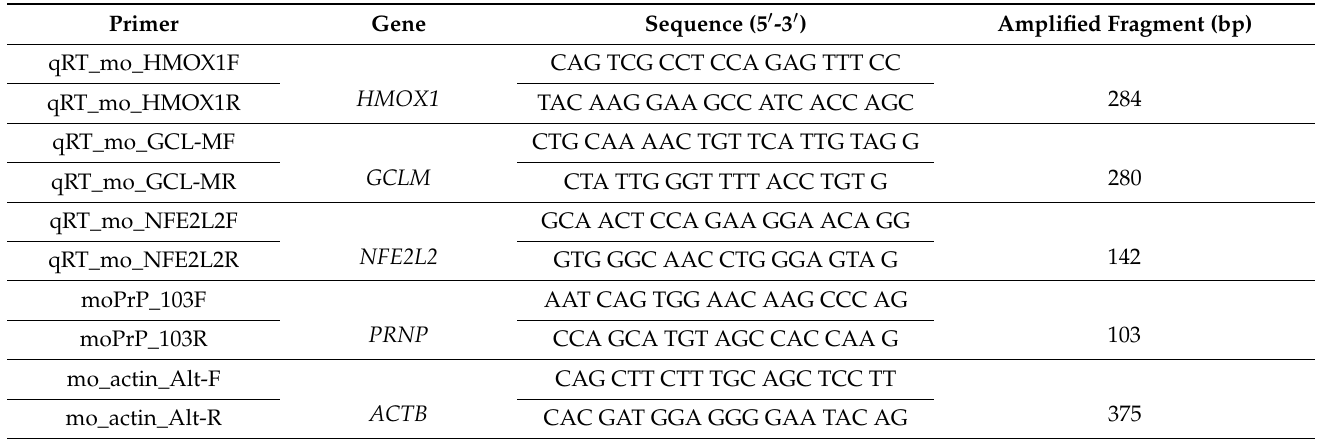
Table 1. Primer sequences used for the amplification of fragments from genes encoding murine